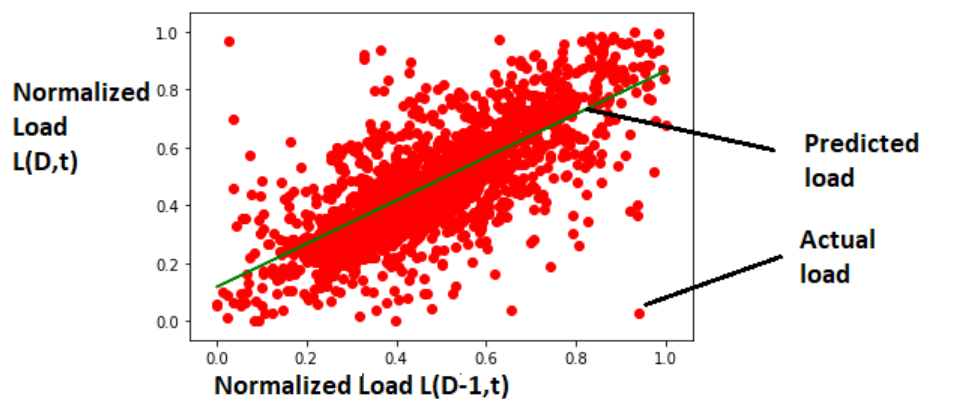
Figure 12. SLR: Distribution of actual load Y a and predicted load with training dataset and with m = 0.7472 and c = 0.1173.